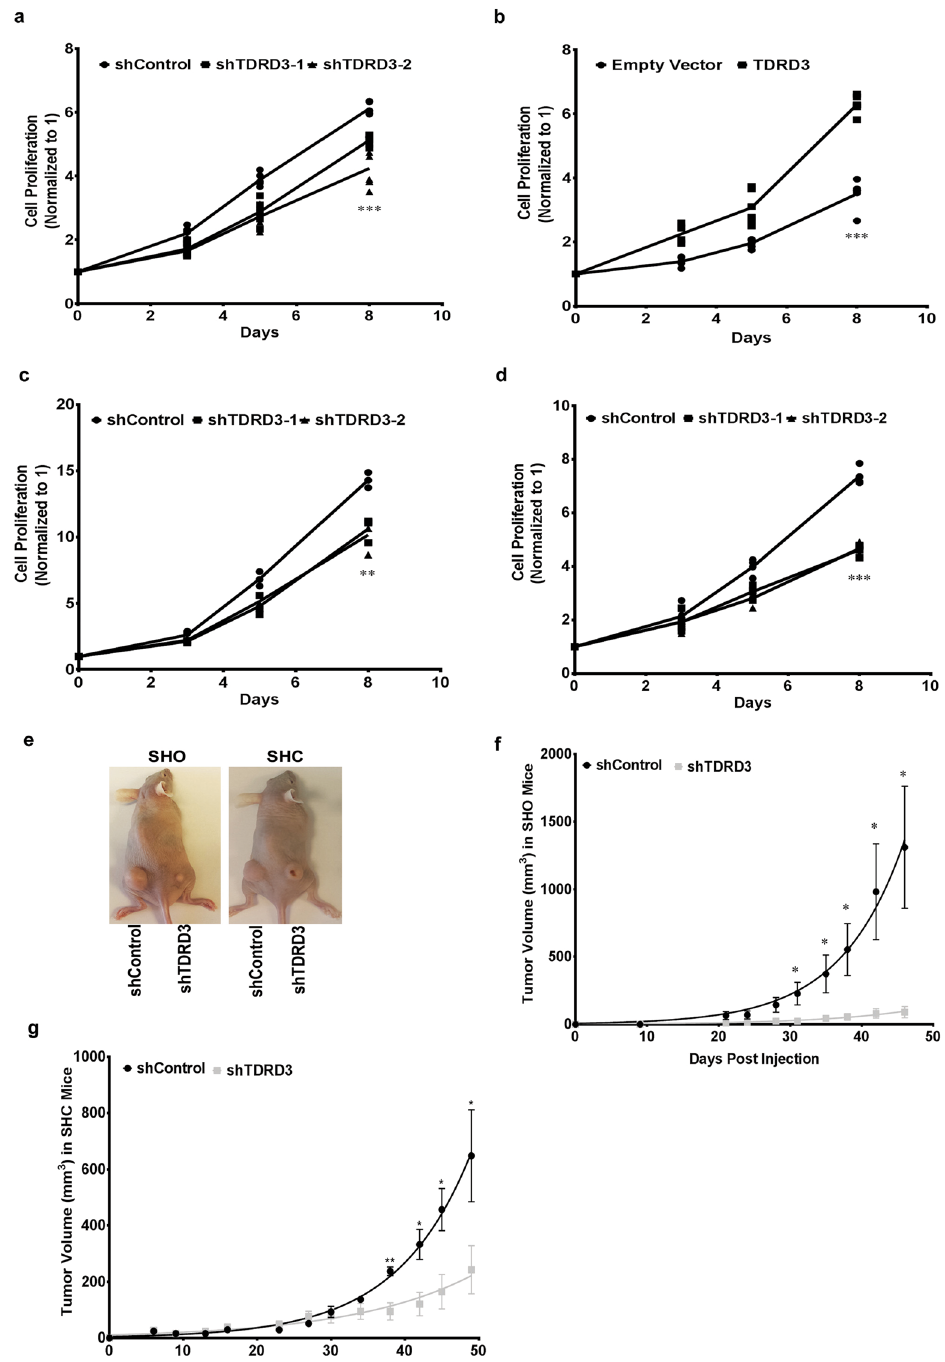
Figure 1. TDRD3 Regulates Cell Proliferation In Vitro and In Vivo . ( a ) MTT assay were performed on MCF7 shControl ( • ), shTDRD3-1 ( ▪ ), and shTDRD3-2 ( ▴ ) cells over a 8 day time course. Data is the mean + / − SEM normalized to 0 h (n = 6, *** p < 0.0001). Significance was determined using a one-way ANOVA. ( b ) MTT assays were performed on MCF7 GFP-tagged empty vector ( • ) or TDRD3 ( ▪ ) cells over a 8 day time course. Data is the mean + / − SEM normalized to 0 h (n = 6, *** p < 0.0001). Significance was determined using a two- tailed t -test. MTT assays were performed on ( c ) MDA MB 231 (n = 3, ** p = 0.0041) and ( d ) Hs578T (n = 4, *** p < 0.0001) shControl ( • ), shTDRD3-1 ( ▪ ), and shTDRD3-2 ( ▴ ) cells over a 8 day time course. Data is the mean + / − SEM normalized to 0 h. Significance was determined using a one-way ANOVA. ( e ) Images of six- week old Crl:SHO- Prkdc scid Hr hr (SHO) and CB17.Cg- Prkdc scid Hr hr /IcrCrl (SHC) mice injected with MDA MB 231 shControl or shTDRD3 cells in their flank. Tumor volume (mm 3 ) of ( f ) SHO (n = 3, Days Post Injection D31 * p = 0.0371) and ( g ) SHC (n = 3, Days Post Injection D38 ** p = 0.0070) mice. Tumor volume measurements are the mean + / − SEM. Significance was determined using a two-tailed t